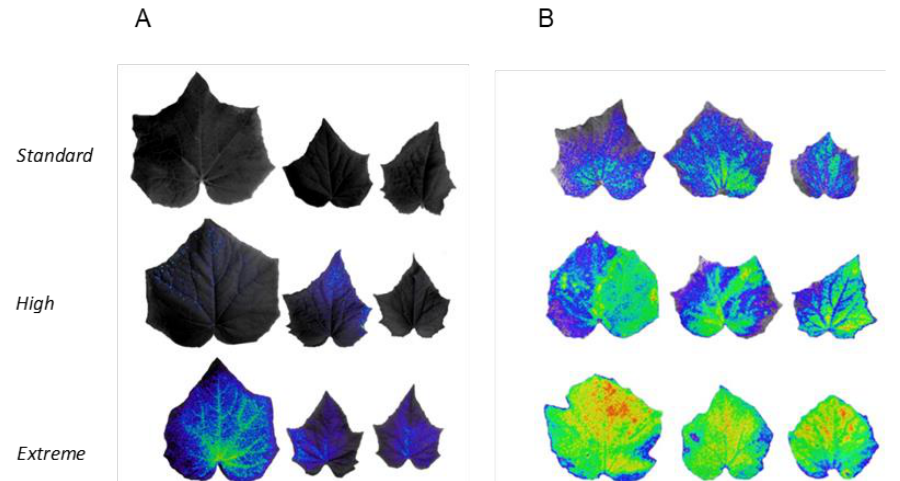
Figure 3. Typical pseudo-colored images based on bioluminescence of typical ( A ) ‘Oitol’ and ( B ) ‘Joker’ cucumber leaves treated with different levels of nitrate concentrations. The photocount-comparison is depicted by pixel peak distributions on 2 D-images represented by pseudo color-coded pixel intensity.